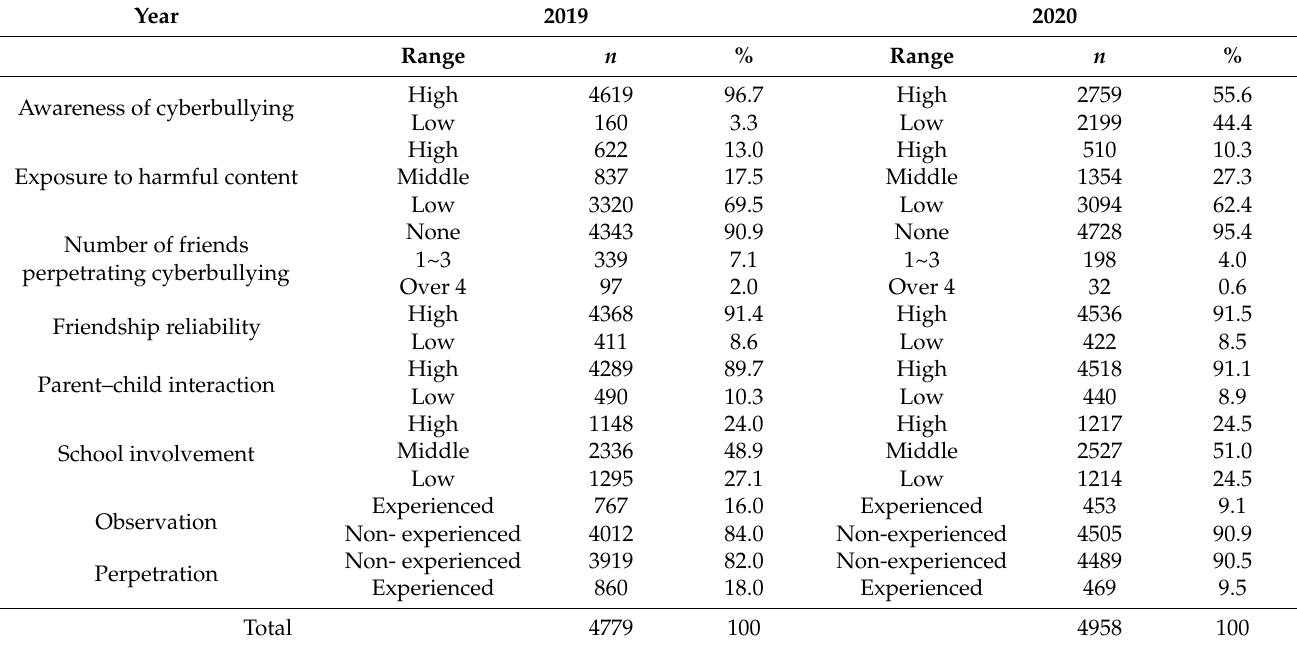
Table 2. Descriptive statistics of the variables.